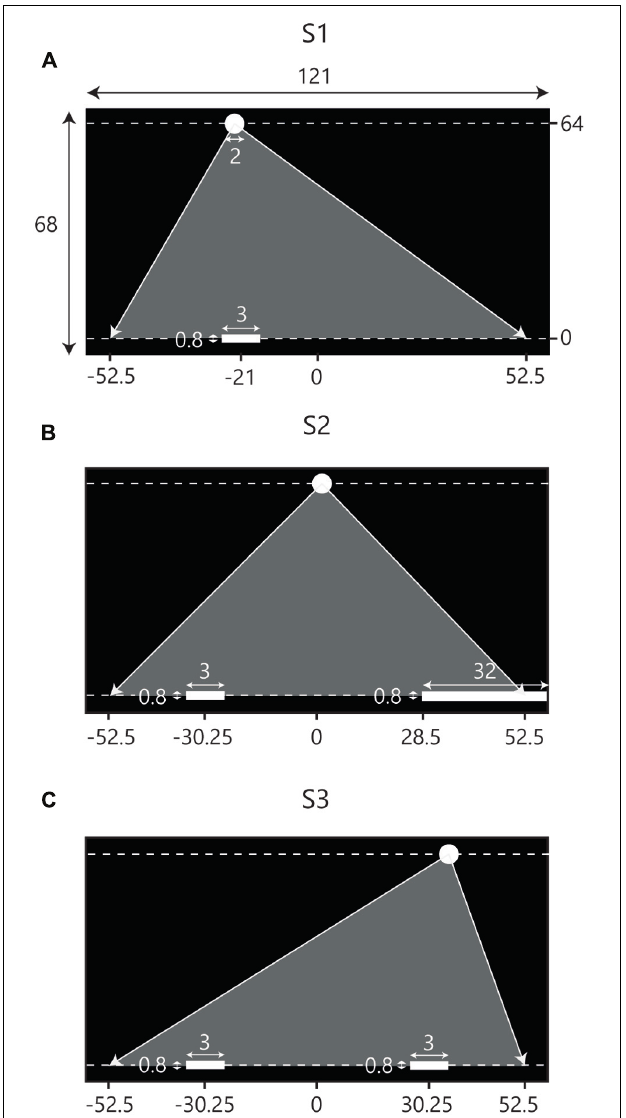
FIGURE 1 | Schematic overview of the set-up of the three consecutive experimental sessions. Screen dimensions and other metrics are in cm. Note that the figures are not scaled to actual size. Balls appeared at the top of the screen ( Y = 64) and moved downward toward the interceptions axis ( Y = 0) at one of two constant vertical velocities. Gray triangles indicate the range of potential ball arrival positions. (A) During the first session (S1) participants intercepted balls individually. The situation depicted here represents the initial conditions for LP. (B) In the second session (S2) participants were assisted by a stationary partner, incorporated by a static paddle covering the final 24 cm of the range of potential ball arrival positions on the opposite side of the interception axis. The situation depicted represents the initial conditions for LP. (C) During the third session (S3) participants intercepted balls in dyads where LP started on the left side of the screen and RP started on the right side of the screen.